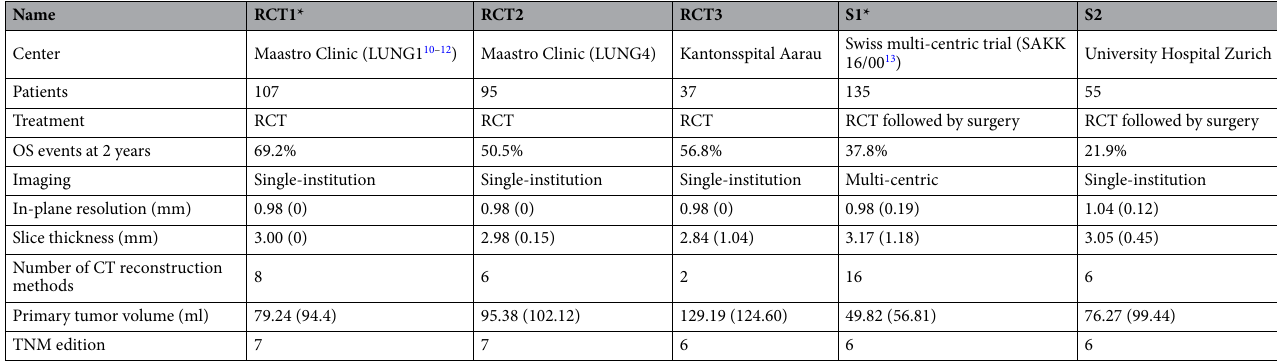
Table 1. Overview of the stage III NSCLC patient cohorts used for this study. Cohorts marked with an asterisk were used to create the decreased survival areas. These cohorts are referred to as exploratory cohorts and the remaining cohorts as independent cohorts. Patients of the independent cohorts were used to extract the smallest distance to decreased survival areas as a potential prognostic factor. Values are reported with mean (standard